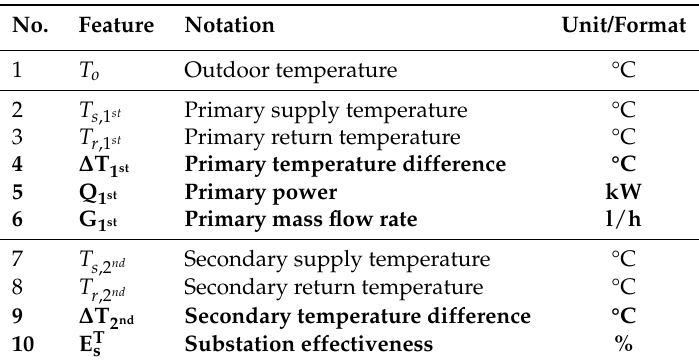
Table 3. Features included in the dataset.